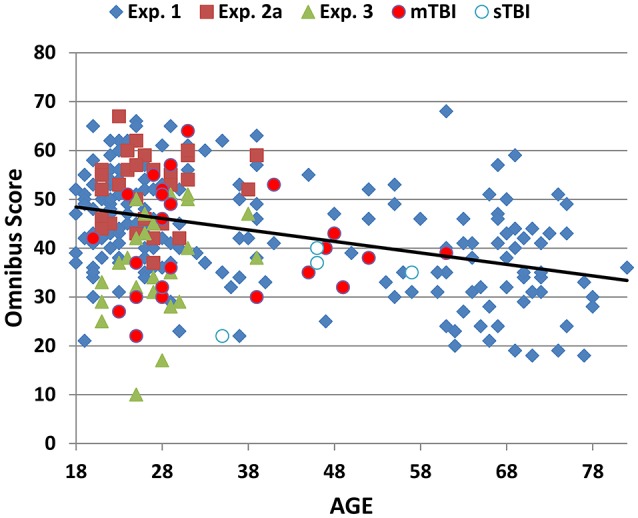
Omnibus scores as a function of age. Omnibus scores were the sum of correctly reported words during the presentation of four acquisition trials (including list B), and two recall trials (IR and DR). Data are shown for normative control subjects in Experiment 1 (blue diamonds), Experiment 2a (red squares), Experiment 3 (Malingering, green triangles), and Experiment 4 with separate data for patients with mild (red circles) and severe (blue and white) TBI.